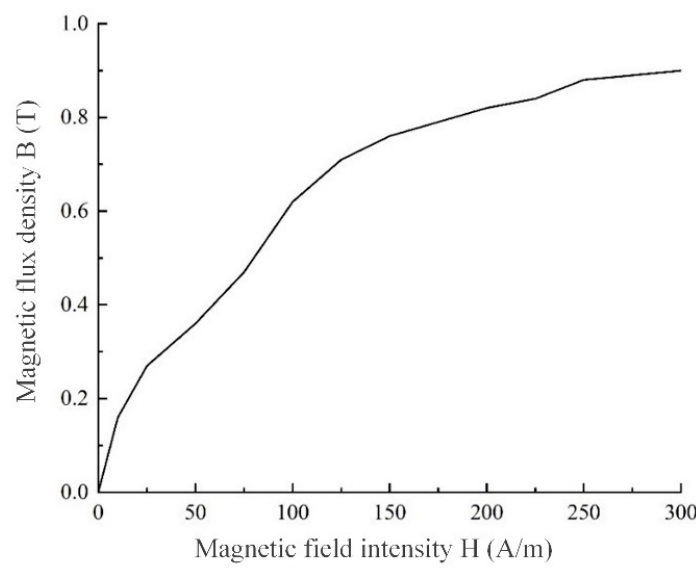
Figure 2. B-H curve of MRF